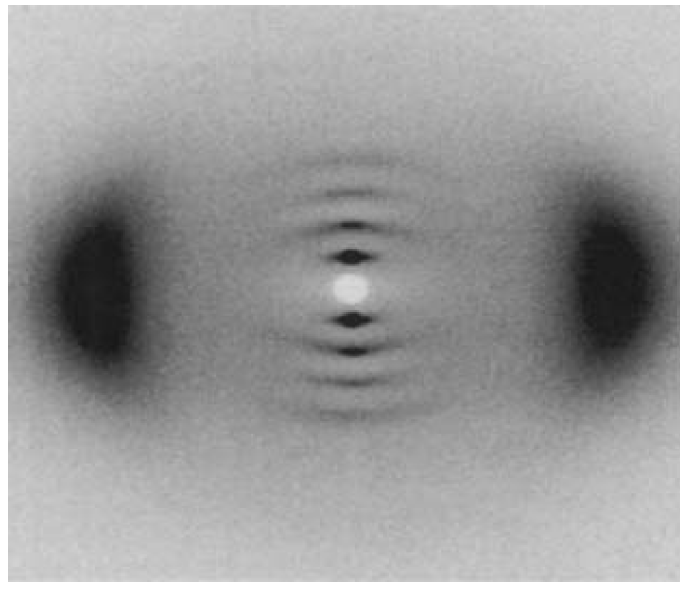
Figure 3. X-ray diffraction pattern of a smectic-A (SmA) monodomain elastomer consisting of a polymer backbone [poly[oxy-(methylsilylene)], two kinds of mesogenic molecules with varying spacer length and concentration, and 10% of rod-like crosslinker; Adapted with permission from [52]. Copyright 1997 American Chemical